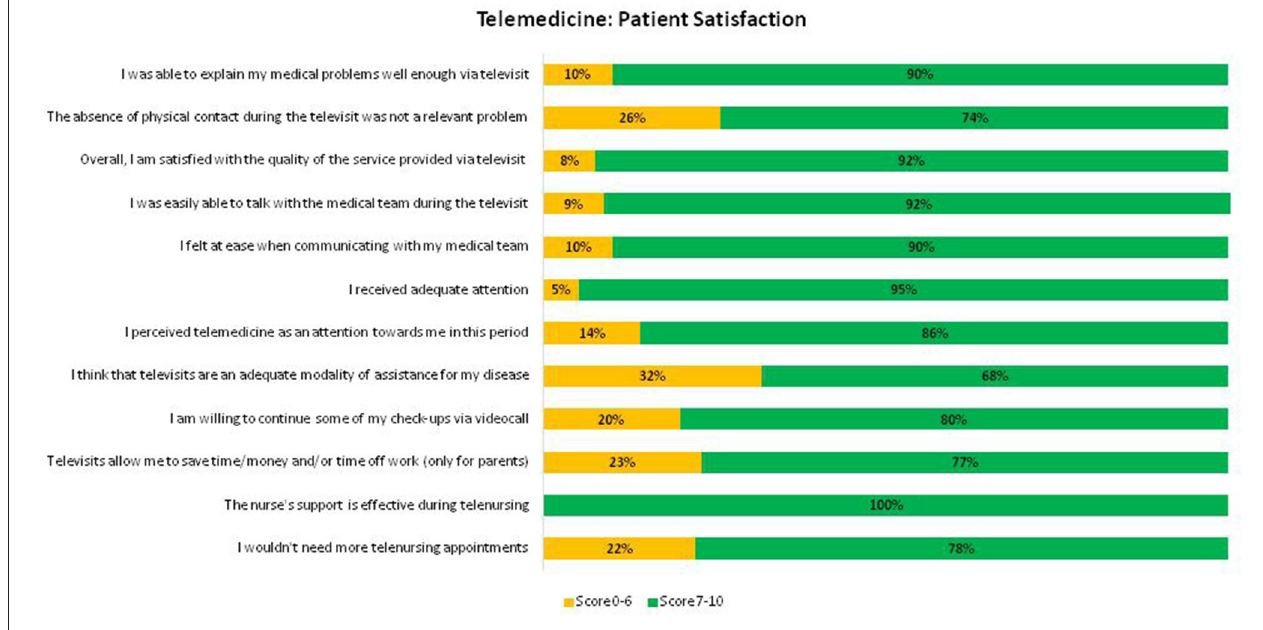
FIGURE 2 | Percentage of patients who were assigned high ( ≥ 7) scores according to main patient and disease characteristics (only significant differences